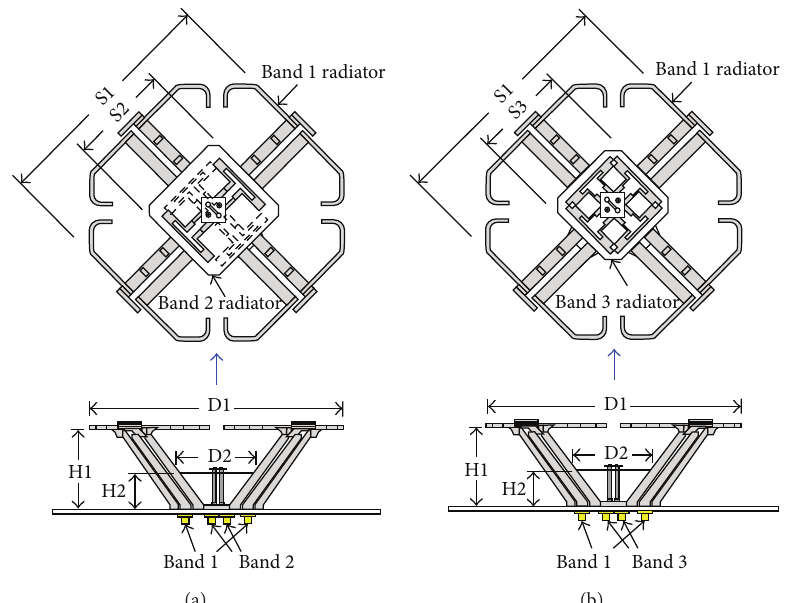
Figure 2: Dual band radiator structure: (a) Band 1 + Band 2; (b) Band 1 + Band 3 (up: top view, down: side view, and large arrow: direction of side